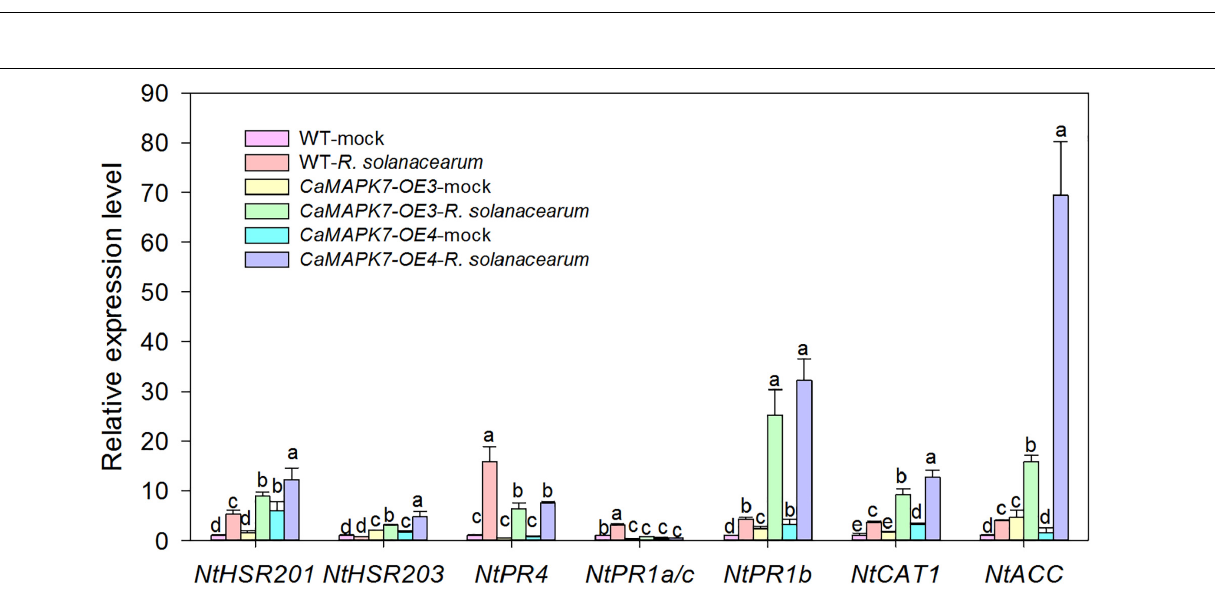
Frontiers in Microbiology |